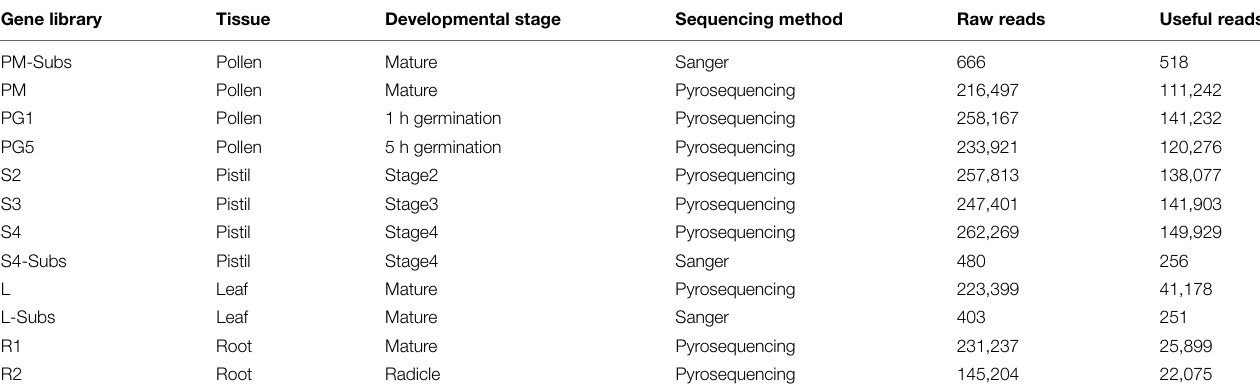
TABLE 1 | Gene libraries used in